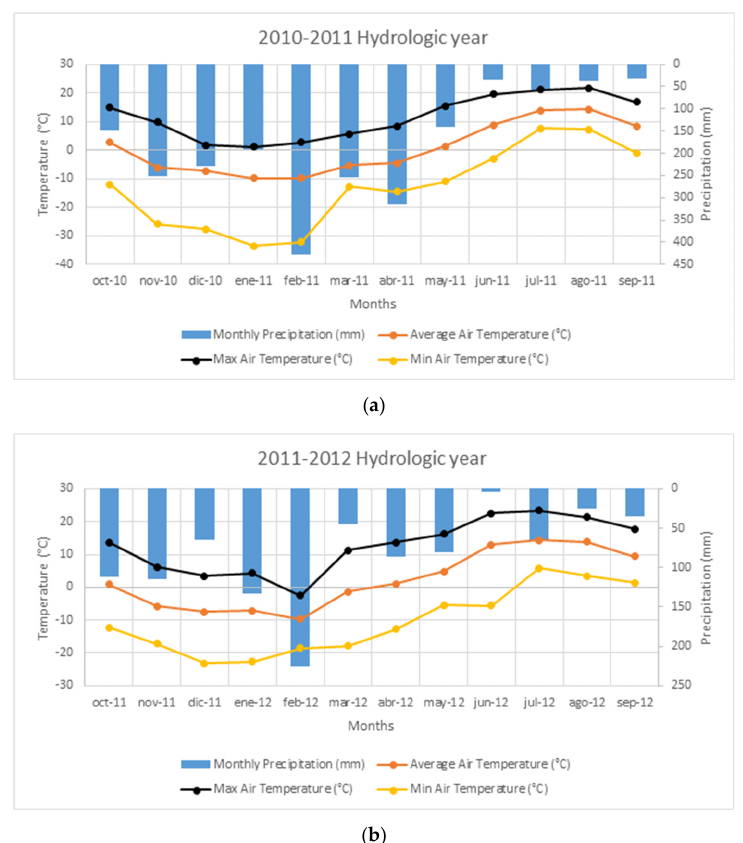
Figure 1. Monthly precipitation (mm) and monthly average, min, and max air temperature (°C) for both hydrologic years 2010–2011 (( a ), upper plot) and 2010–2012 (( b ), lower plot).